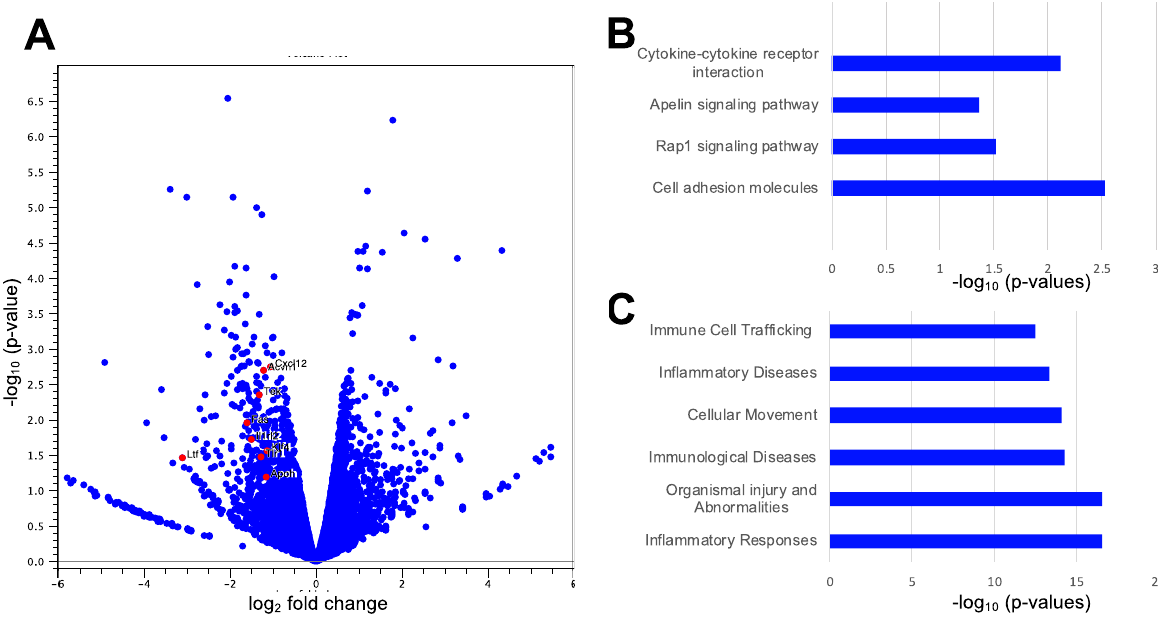
Figure 4. Sorbinil downregulates inflammatory-related signaling pathways one week after ONC. (A) The volcano plot shows differentially expressed (DE) genes associated with immune response that are downregulated in the whole retina one week after ONC (Sorbinil versus DMSO; p- value ≤ 0.1 and fold change is less than -2). (B) Pathway enrichment analysis using the KEGG database highlights the downregulation of various immune response-associated pathways one week after ONC with Sorbinil treatment. (C) The top 6 diseases and functions associated with the downregulated DE genes were determined by Ingenuity Pathway Analysis software. . N = 2 mice per Sorbinil group; N = 3 mice per DMSO